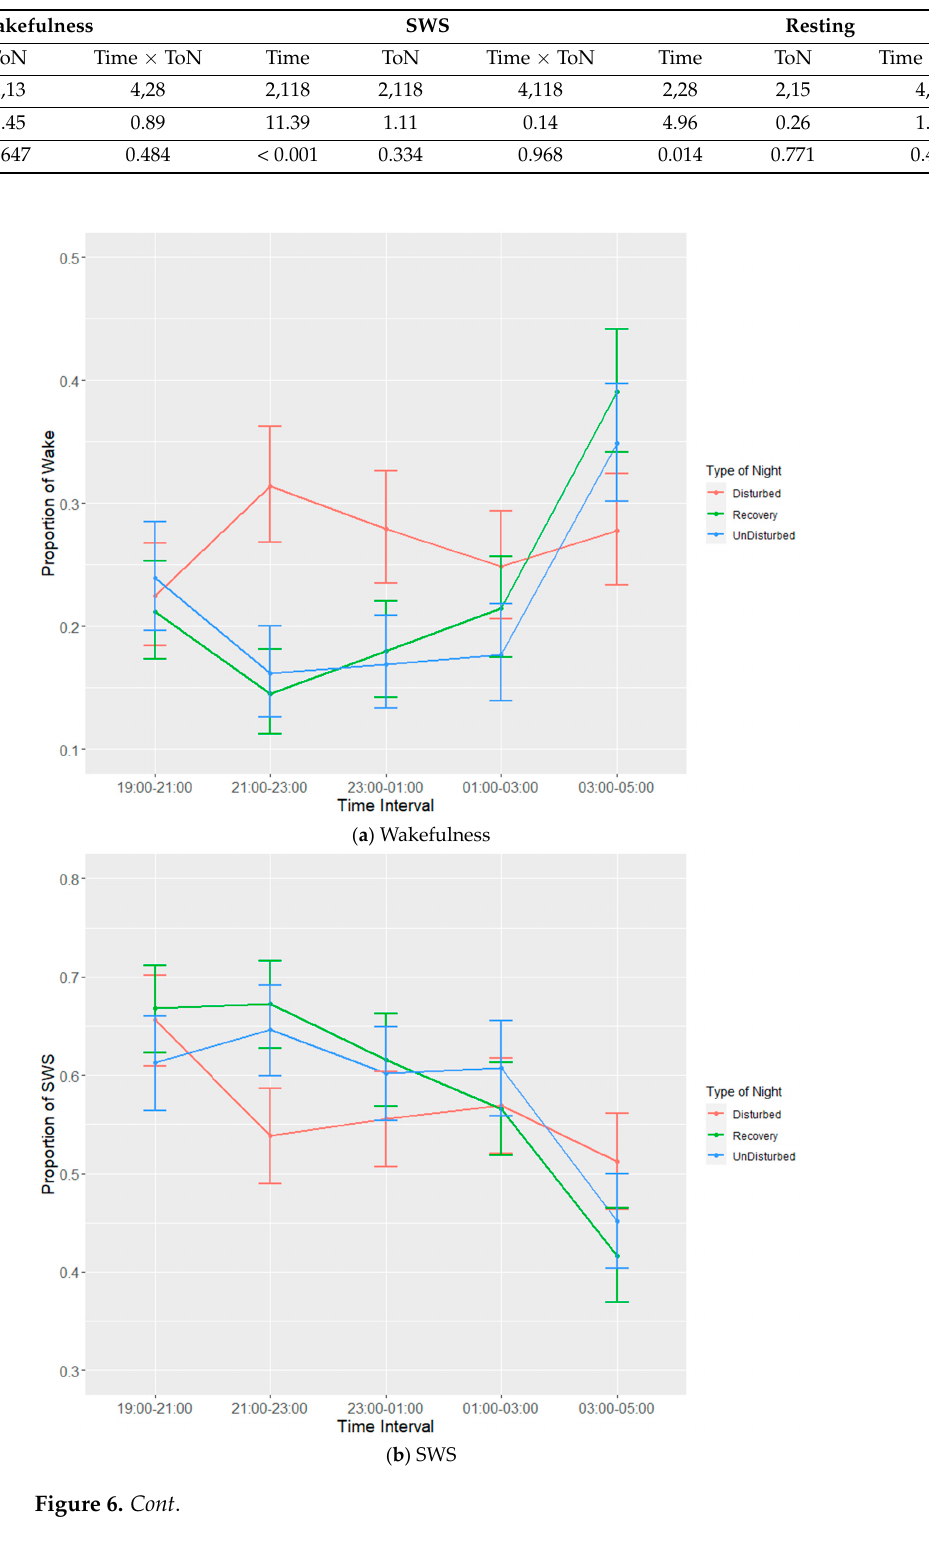
Table 7. F tests for effects of time interval (‘Time’, 3.5 h blocks), type of night (‘ToN’; disturbed, recovery and undisturbed) and their interaction (Time × ToN) on wakefulness, slow-wave sleep (SWS) and resting during lights on from LMMs. F values and numerator and denominator degrees of freedom (ndf,ddf, respectively) are shown.